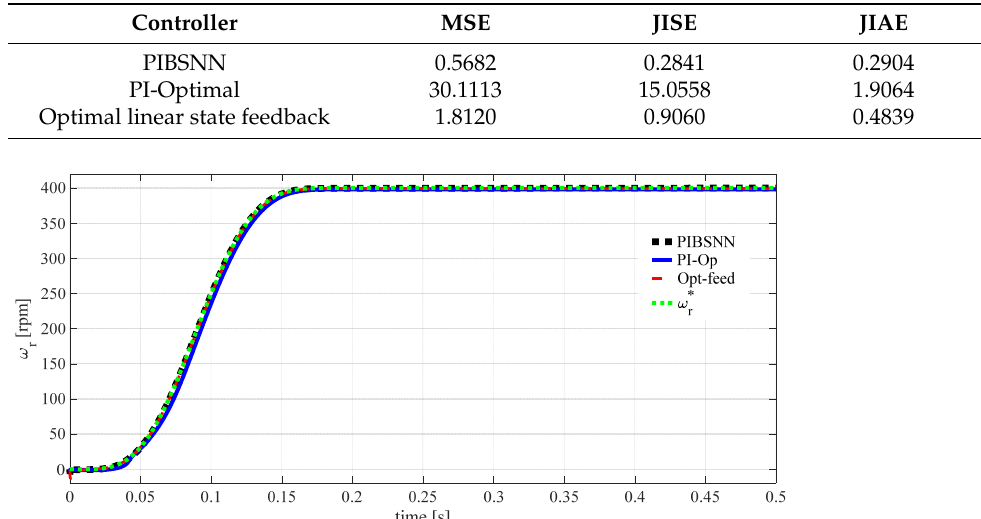
Table 3. Speed error performance indices for case 1.